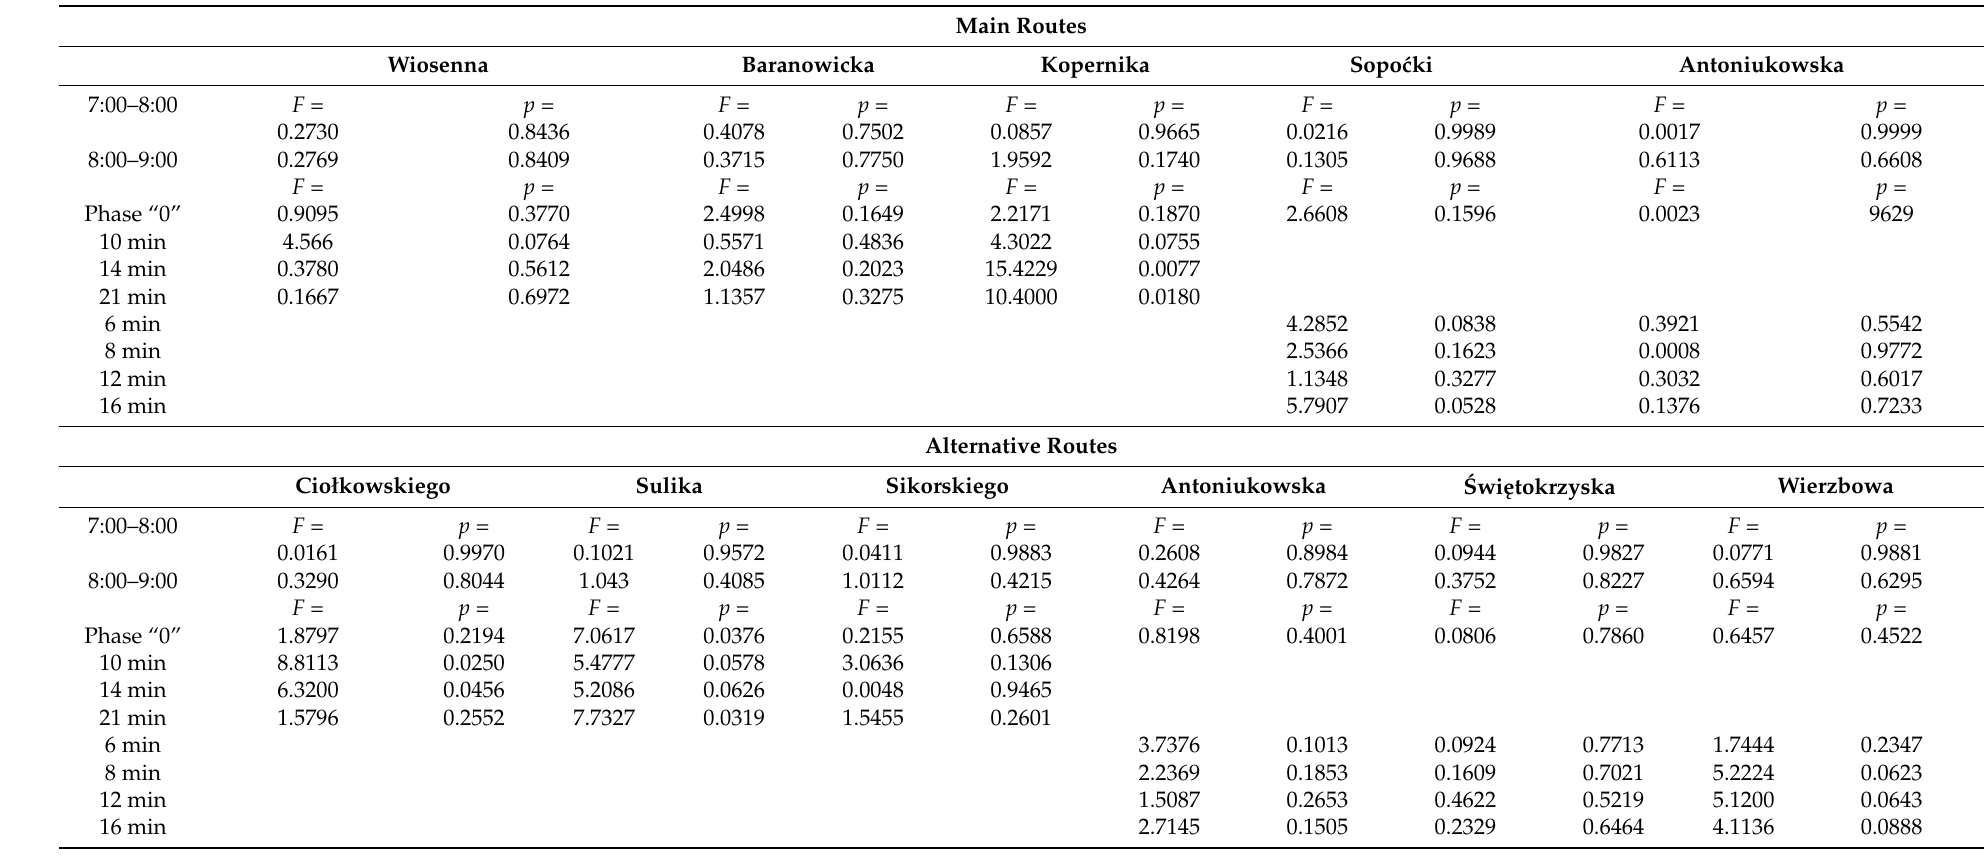
Table A1. ANOVA results for hourly traffic fluctuations (elongated